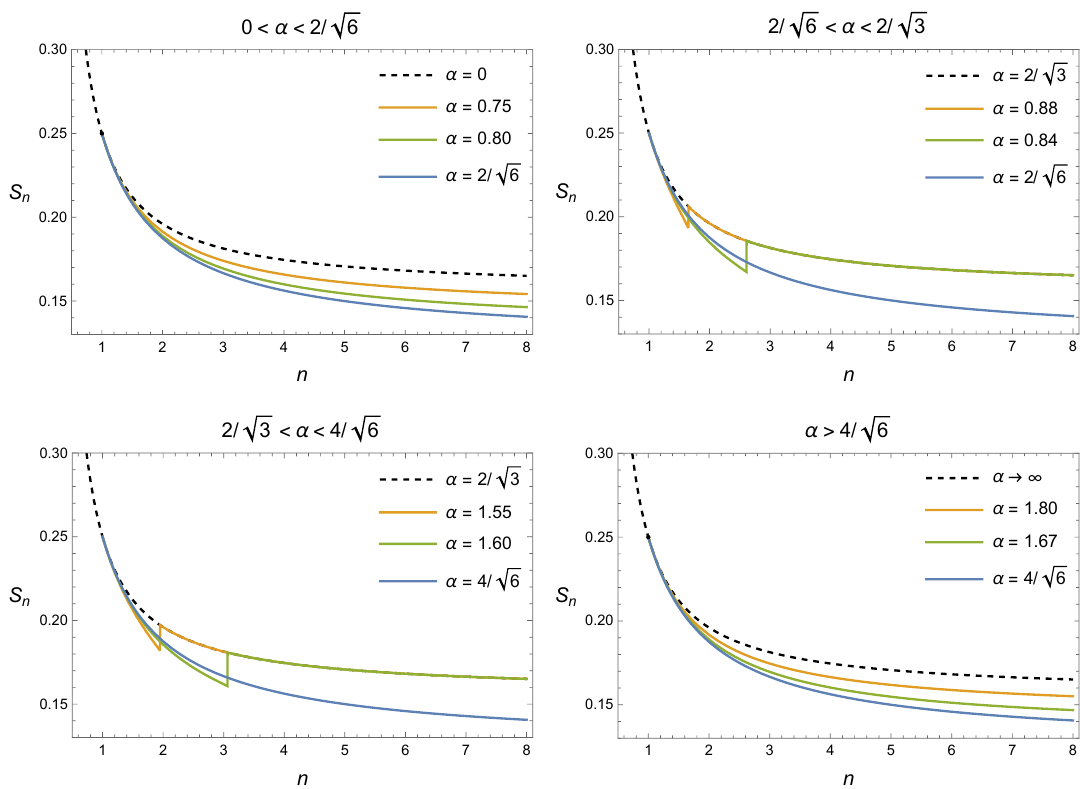
√ √ 6 or 4 / 6 . A third-order phase transition occurs